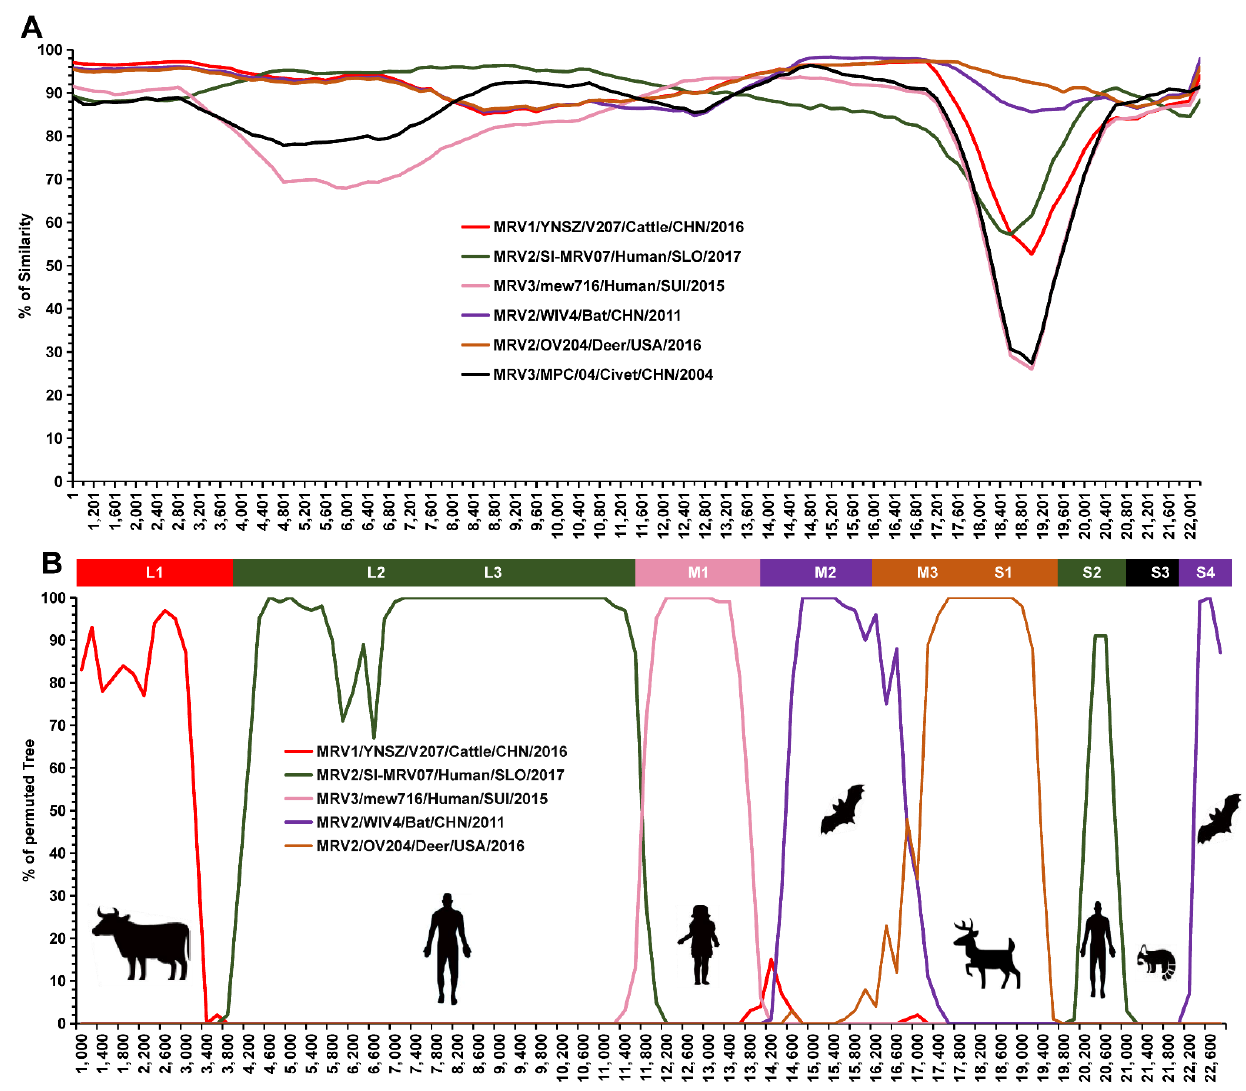
Figure 5. Reassortment analysis of BtMRV-QAPpC66 and other MRVs. ( A ) Similarity plots and ( B ) bootscan analyses were performed with the concatenated segments of BtMRV-QAPpC66 as the query and other MRVs, including MRV1/YNSZ/V207/Cattle/CHN/2016, MRV2/SI-MRV07/Human /SLO/2017, MRV3/mew716/Human/SUI/2015, MRV2/WIV4/Bat/CHN/2011, MRV2/OV204/Deer/ USA/2016 and MRV3/MPC/04/Civet/CHN/2004, as potential parental sequences.